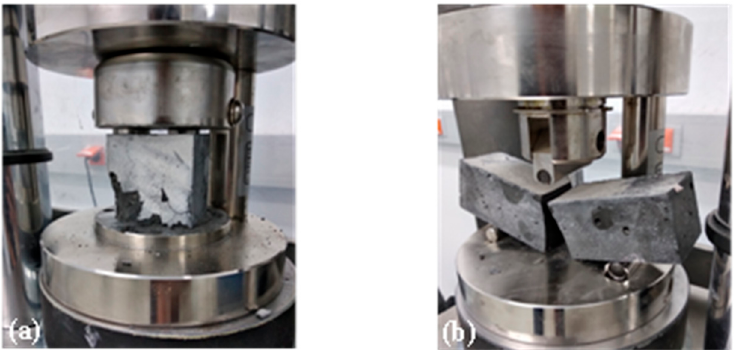
Figure 1. Strength test setup: ( a ) compressive strength test; ( b ) flexural strength test.